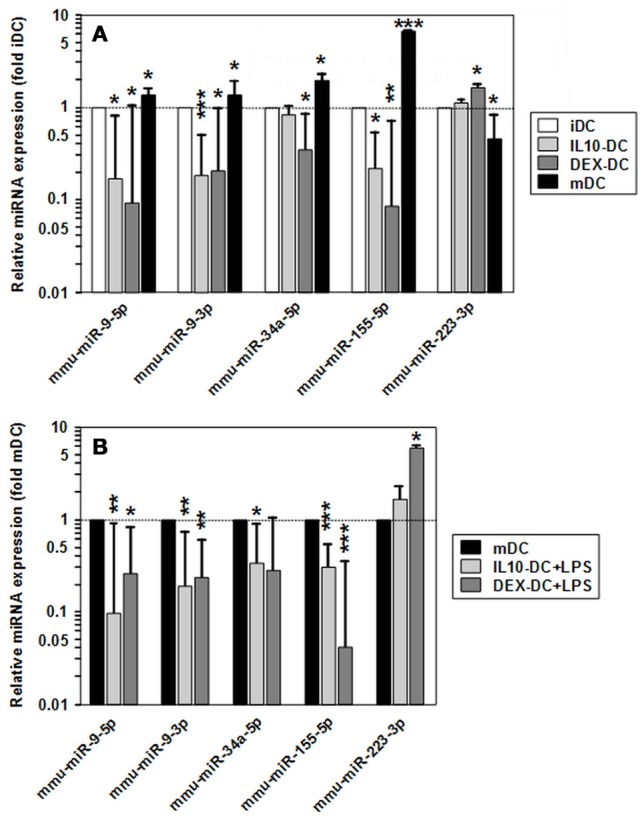
Validation of differential miRNA expression in tolerized APCs vs. BMDCs. Levels of mature miRNA expression in tolerized APC populations and BMDCs at (A) unstimulated and (B) LPS-stimulated state were assessed by real time PCR. To indicate stimulation-dependent alterations in miRNA expression in BMDCs, according levels in mDCs as compared with iDCs are given in (A). (A,B) Data indicate the mean ± SEM of 4 independent experiments performed in duplicate. Statistically significant differences: *vs. corresponding control DC population (iDC,mDC) (*p < 0.05, **p < 0.01, ***p < 0.001).